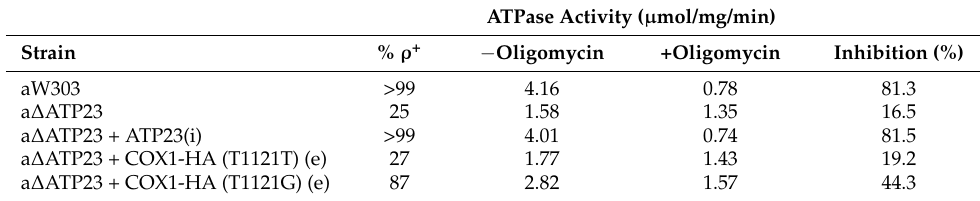
Table 2. Mitochondrial ATPase activity and oligomycin sensitivity of transformants.